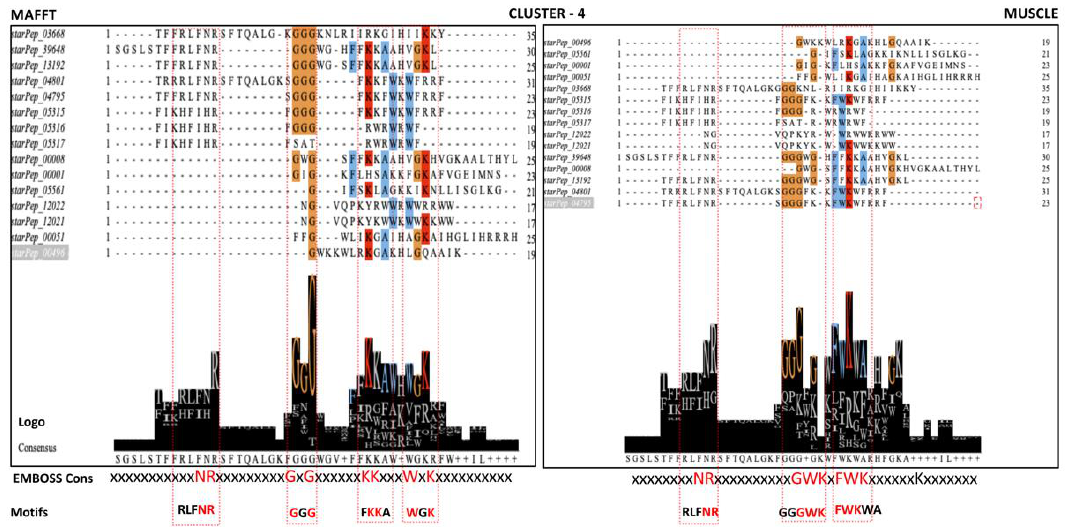
Figure 11. Motif detection by the multiple sequence alignment (MSA) algorithms MAFFT and MUS- CLE on the network cluster 4. The MSAs are visualized with the Jalview program, which also esti- mates a Seq2Logo and the consensus from the alignment positions. Another consensus sequence that served as a guide for motif location was estimated by the EMBOSS